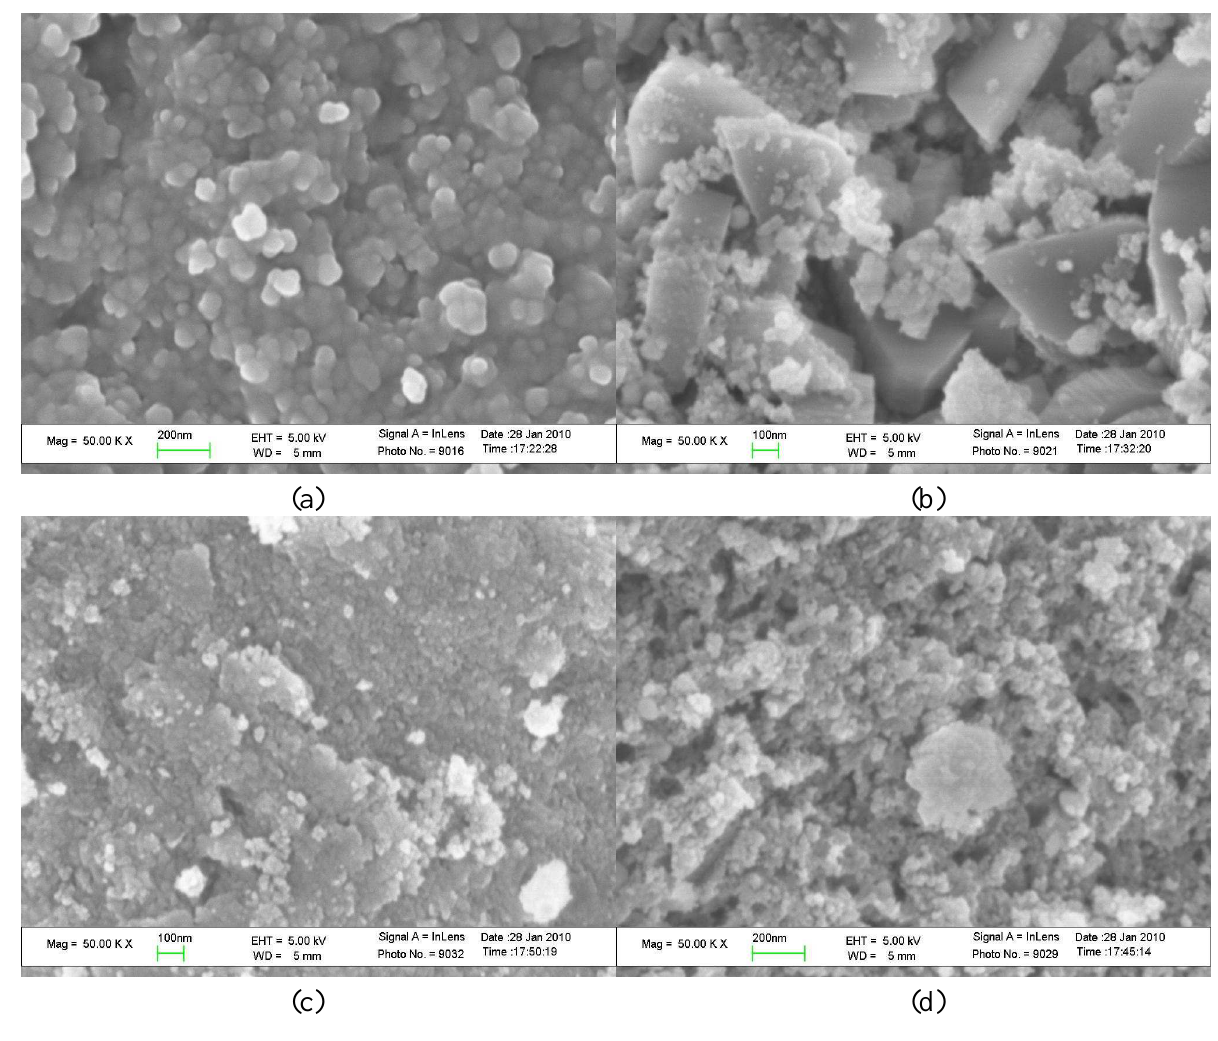
Figure 4. SEM photographs of Ni-based catalysts: (a) RE1NAR-80-20; (b)